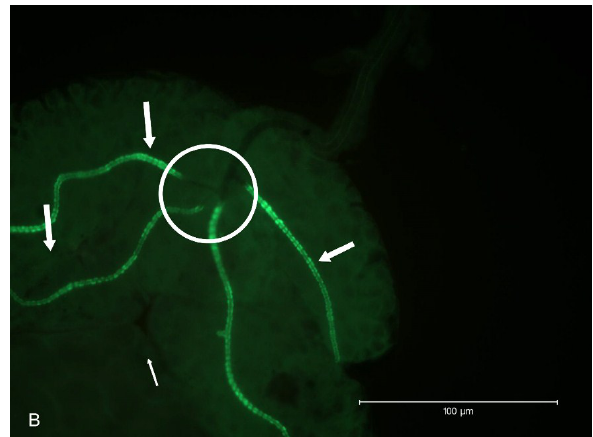
Figure 2. Epifluorescent immunodetection of HSPG to SG ducts from Ae. albopictus . ( A ) Fluorescence image of two sets of SG’s immunolabeled for HSPG using monoclonal antibody C17. Two main ducts (MD) are apparent. Each single tri-lobed SG is composed of two longer lateral lobes (LL) and a single shorter median lobe (ML). Internal ducts (thick arrows) stained positive for HSPG in the LL, and internal ducts (thin arrows) in ML are deficient of detectable HSPG; ( B ) Higher magnification of a SG labeled for HSPG. This aberrant SG has four LL’s instead of the usual two; hence the triad structure (circle) has five instead of three internal ducts entering the MD ([10]; See SG diagram). Positive fluorescence